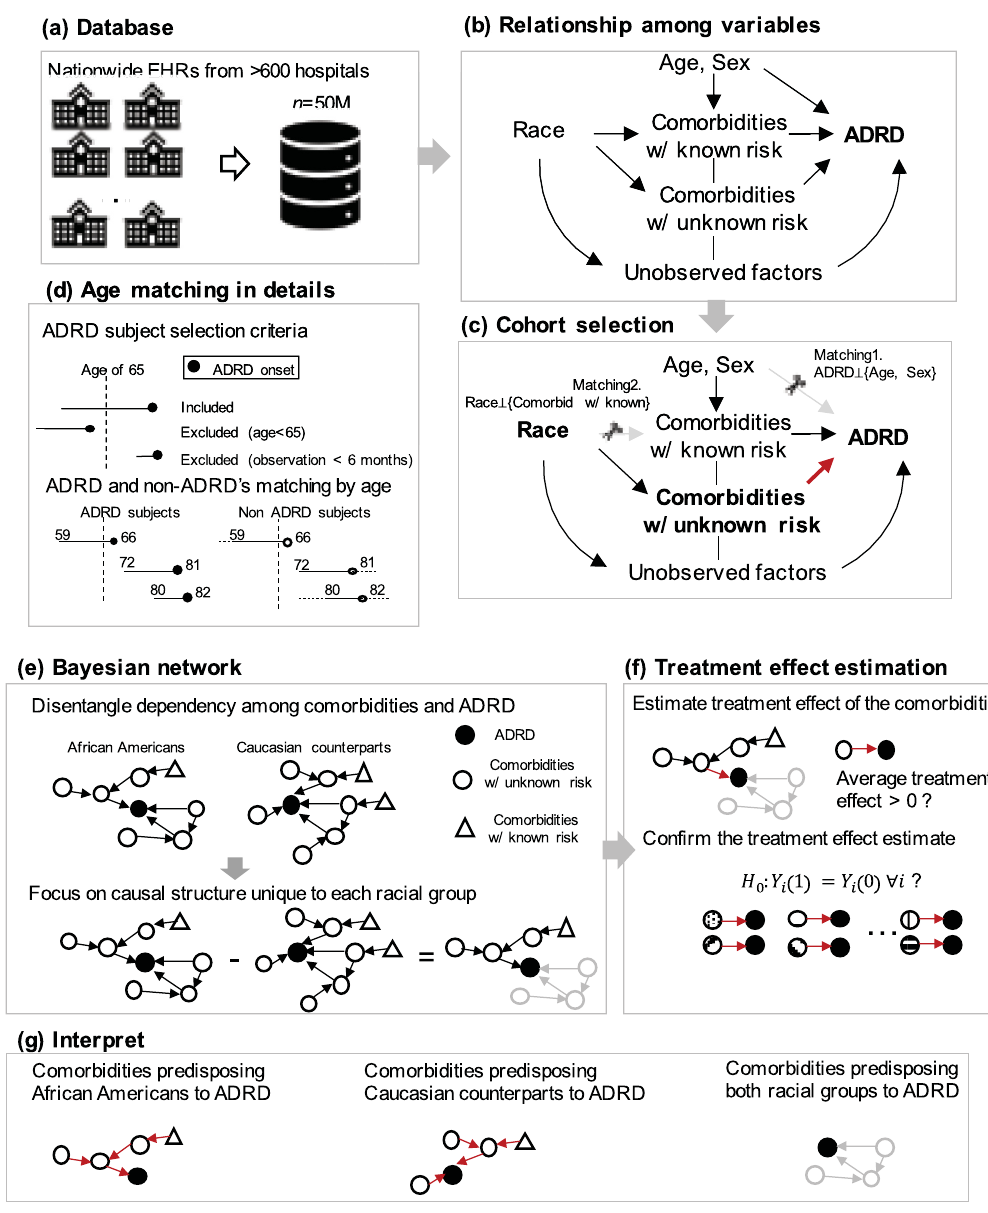
Fig 1. Study overview. Our goal is to assess the counterfactual effect of comorbidities that predispose each racial group to ADRD. We focused on African Americans and non-Hispanic Caucasians. (a) We used Cerner EHRs from more than 600 Cerner client hospitals. (b,c) To select cohort, we matched age and sex in ADRD and non-ADRD subjects. To make African American and Caucasian cohorts comparable, we matched race on the known ADRD risk factors (age, sex, hypertension, diabetes, obesity, heart disease, vascular disease, and head injury). Hidden confounders (such as socioeconomic status) were presented for clarification. (d) Age is the strongest risk factor in ADRD. We matched the age of ADRD and non-ADRD subjects. (e) To disentangle the multifactorial effect of comorbidities, we derived a Bayesian network of comorbidities and ADRD using constraint-based algorithms. (f) We used inverse probability of treatment weighting to estimate the counterfactual effect of comorbidities that have a direct edge to ADRD in each racial group’s Bayesian network. We performed the permutation test to validate the counterfactual effect. (g) We examined the difference in comorbidities paths of the Bayesian network.